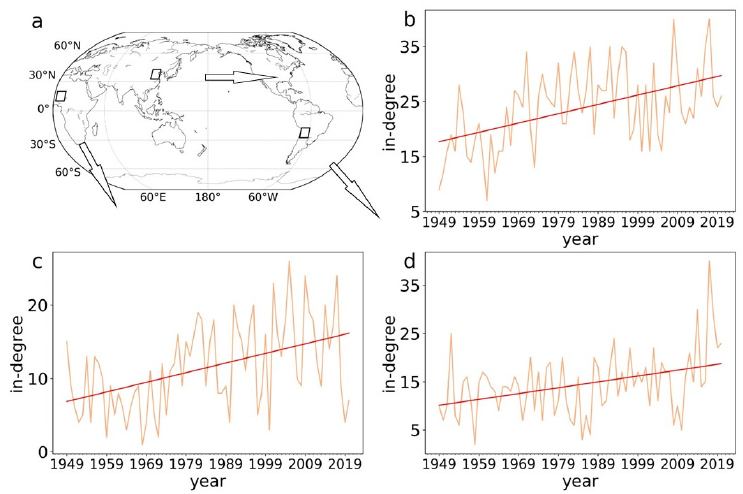
Figure 4. Examples of time series of in-degree from 1949 to 2020 for three hot spots in ( b ) East Asia, ( c ) North Africa, and ( d ) South America, respectively. The black boxes show the selected hot spots ( a ). The red lines are the best-fitted linear lines. Each arrow in panel ( a ) points to subgraph ( b ), ( c ), and ( d ), respectively.